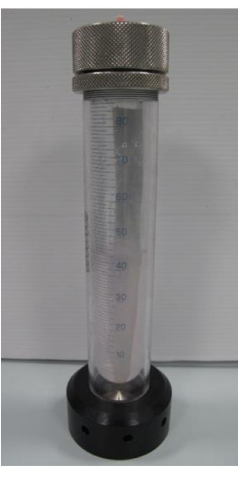
Figure 2. Pack test